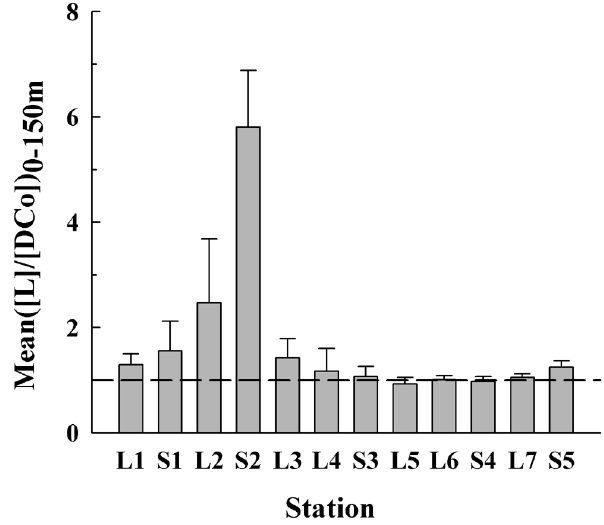
Fig. 5. Meridional trend of mean [L]/[DCo] picomolar ratios aver- aged in the upper 150m at stations L and S (the northern station is L1 on the left, the southern is S5 on the right). Dashed line repre- sents mean [L]/[DCo] of